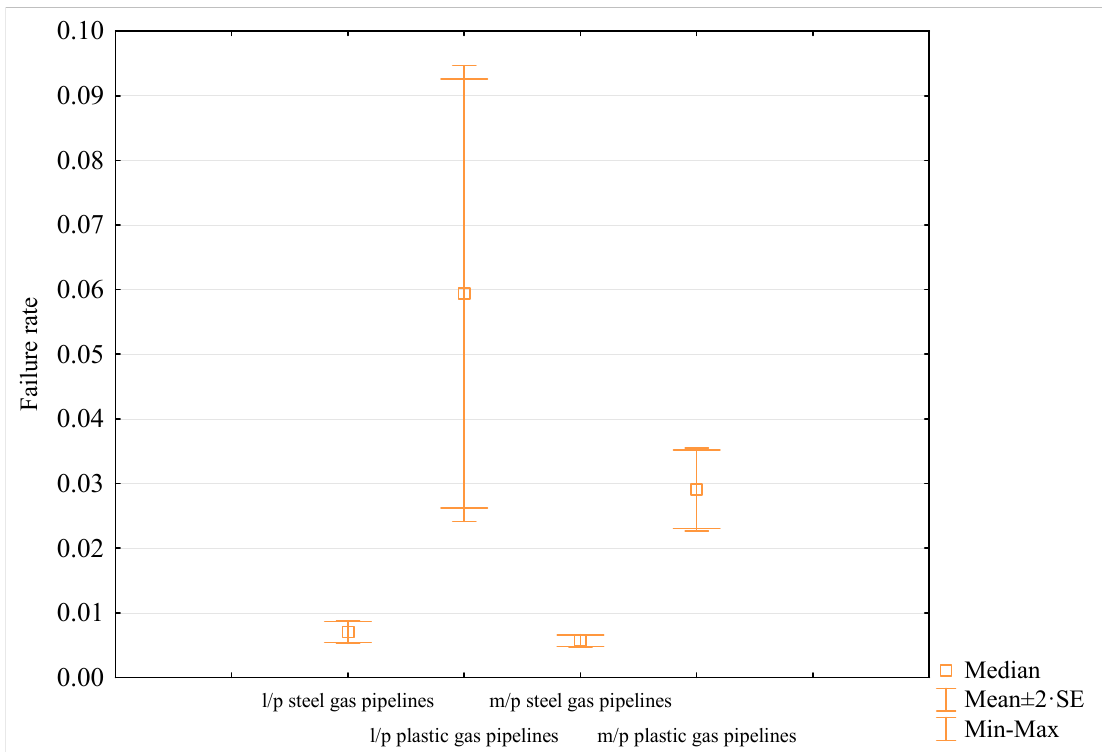
Figure 4. Failures in l/p and m/p gas networks with a percentage breakdown by causes, where: ( a ) is the m/p gas network (plastic), ( b ) the m/p gas network (steel), ( c ) the l/p gas network (plastic) and ( d ) the l/p gas network (steel). The failure rate index determined based on Formula (2) is presented in Figure 5.